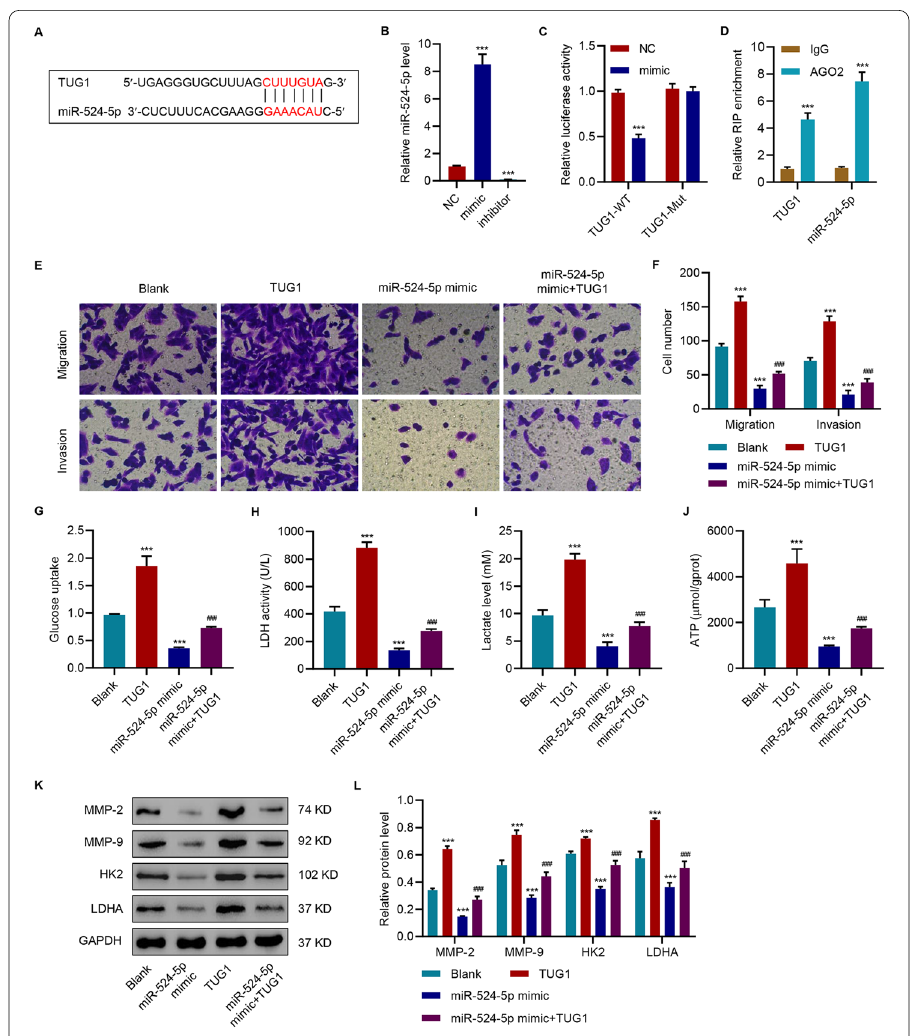
Fig. 4 TUG1 attenuates miR-524-5p mimic-mediated anti-tumor effects in HepG2. A The predictive binding of miR-524 and TUG1. Relative levels of miR-524 B in HepG2 cells with overexpression or silencing of miR-524-5p. C Binding of miR-524 and TUG1. D RIP experiments were performed in HepG2 cells with an AGO2 antibody, and the co-precipitated RNA was subjected to qPCR for TUG1. Effects of TUG1 overexpression and miR-524 mimic on ( E , F ) migration and invasion, ( G ) glucose uptake, ( H ) LDH activity, ( I ) lactate, and ( J ) ATP content, and ( L , M ) expression of MMP-2, MMP-9, HK2, and LDHA. The data are expressed as the mean SD (n 3). *** P < 0.001 vs. blank or NC. ### P < 0.001 compared with miR-524 ± =